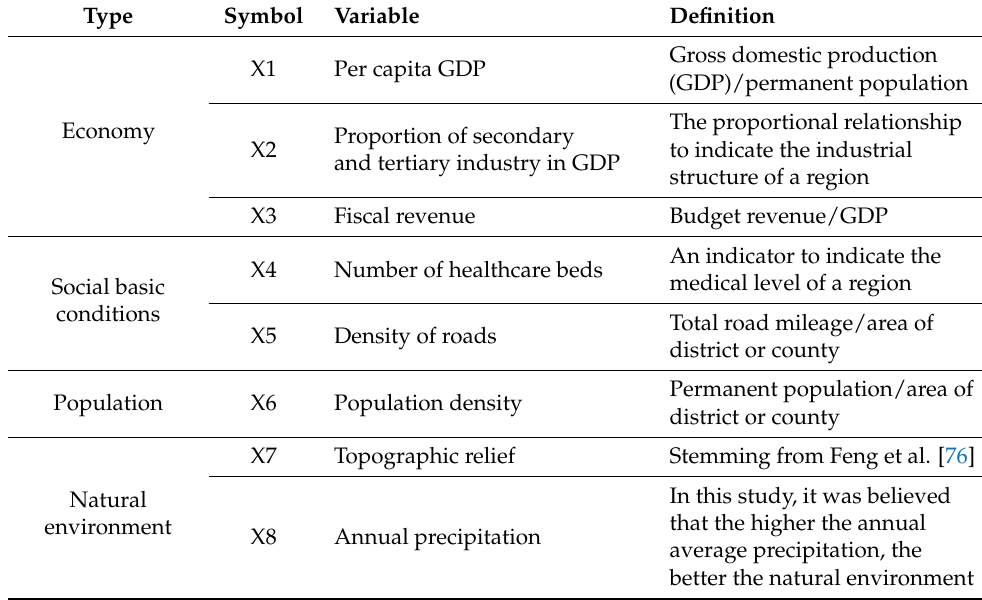
Table 1. Indicators to analyze the driving factors of